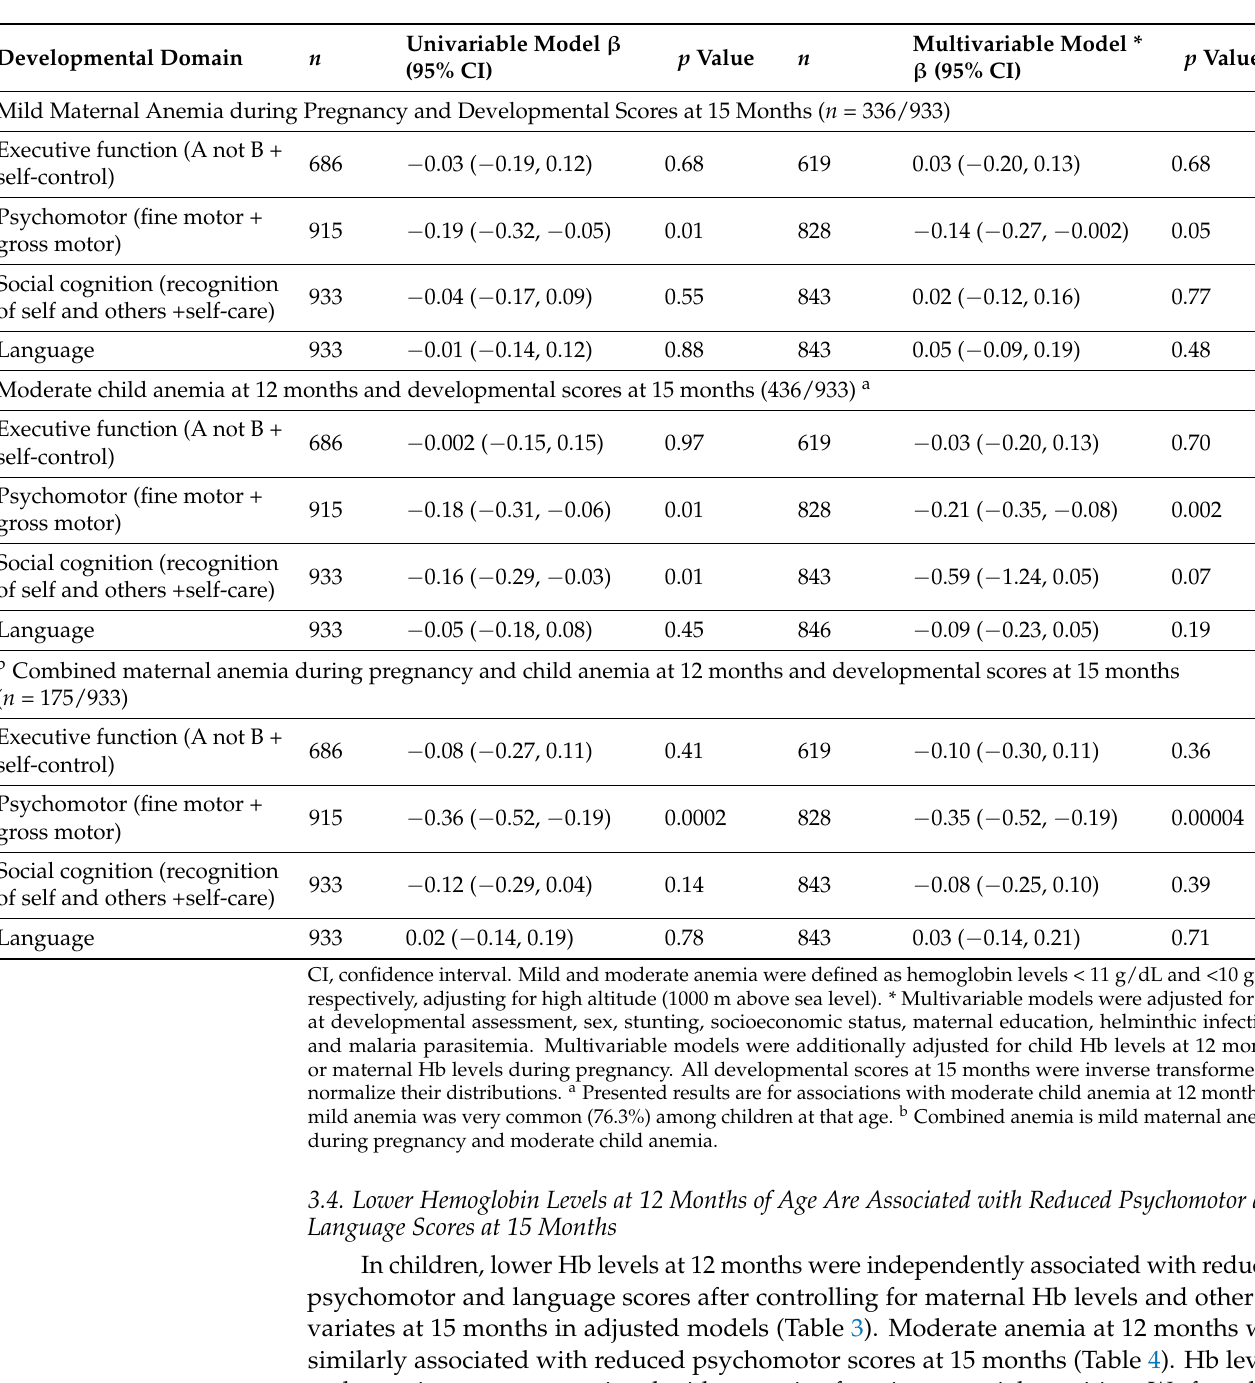
Table 4. Multivariable linear regression results for associations between maternal and child anemia and developmental scores at 15